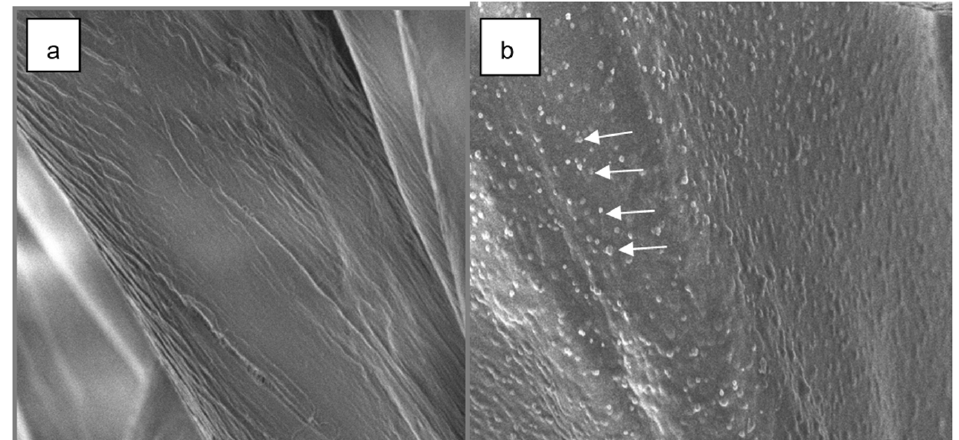
Figure 4. Image under scanning electron microscope (SEM) of the control ( a ) and functionalized ( b ) fabric with AgNPs-CMC nanocomposite. The arrows indicate brilliant particles uniformly distrib- uted, representing the silver nanoparticles in the fabric.